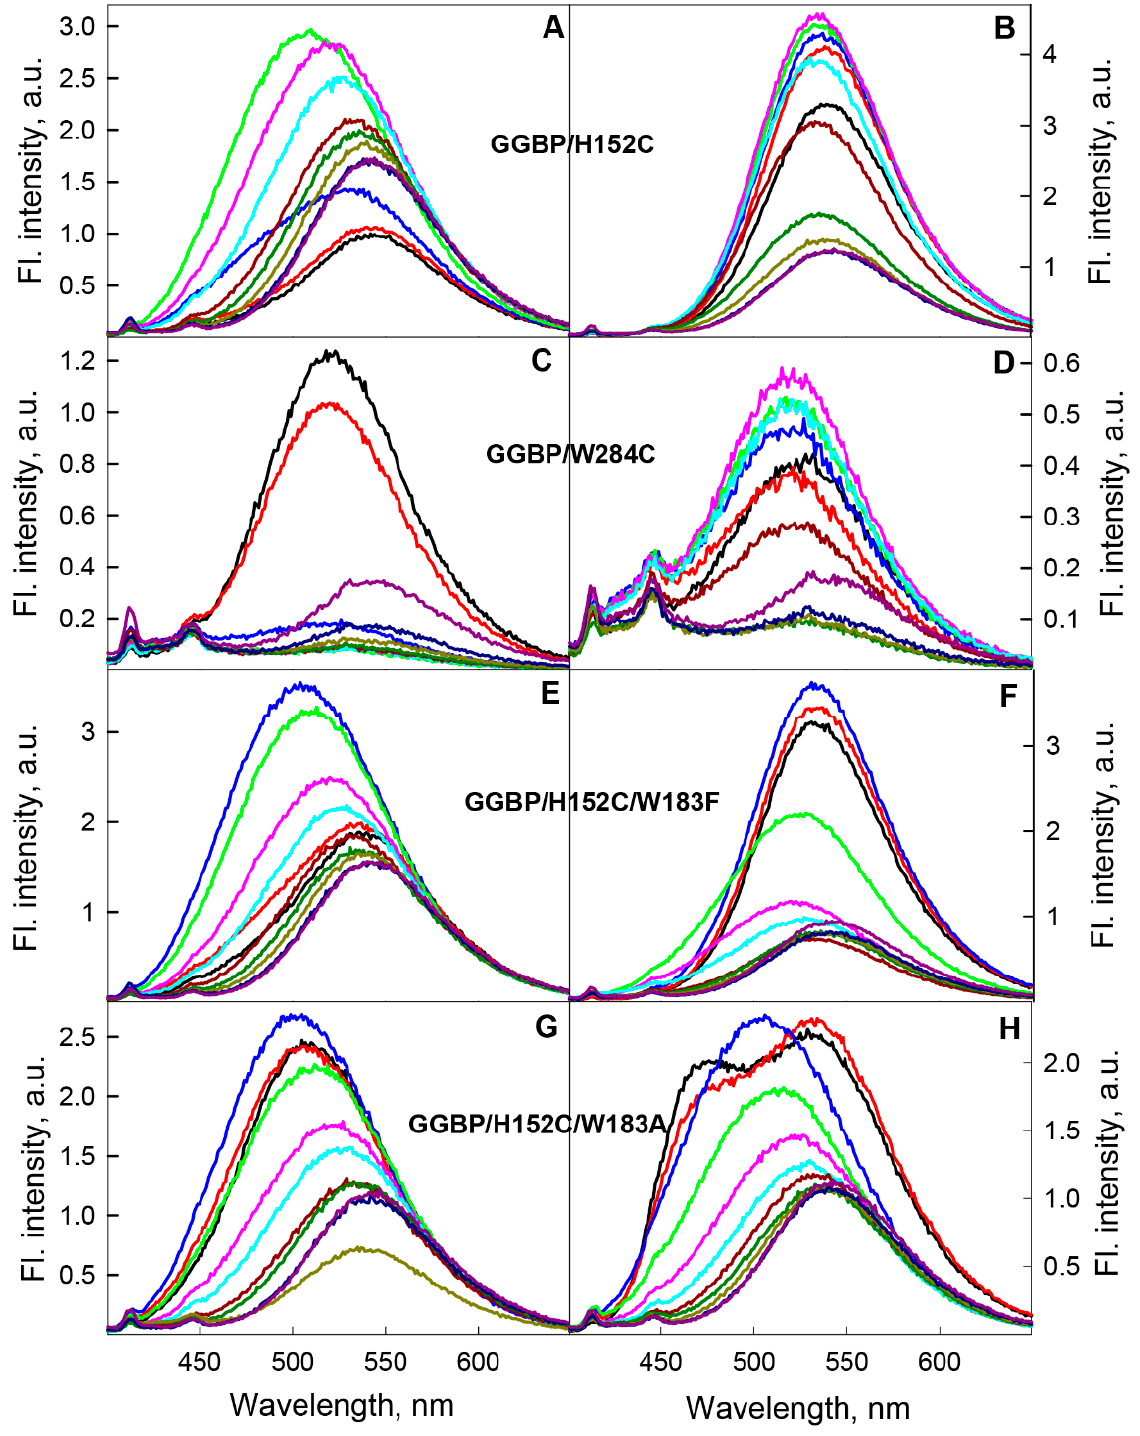
Figure 8. Fluorescence spectra of BADAN linked to mutant forms of GGBP in apo ( left panels ) and holoform ( right panels ) in GdnHCl solutions. Panels ( A – H ) Spectra of GGBP/H152C, GGBP/W284C, GGBP/H152C, GGBP/H152C/W183F, and GGBP/H152C/W183A. Black, red, blue, green, pink, blue, dark red, dark green, dark yellow, dark blue, and violet curves characterize the BADAN fluorescence spectra in solutions containing 0, 0.1, 0.3, 0.5, 0.7, 0.9, 1.2, 1.5, 2, 3, and 4 M GdnHCl, respectively. The fluorescence intensity of BADAN under all experimental conditions was normalized to the fluorescence intensity of the dye attached to the GGBP/H152C apoform. The excitation wavelength was 387 nm.